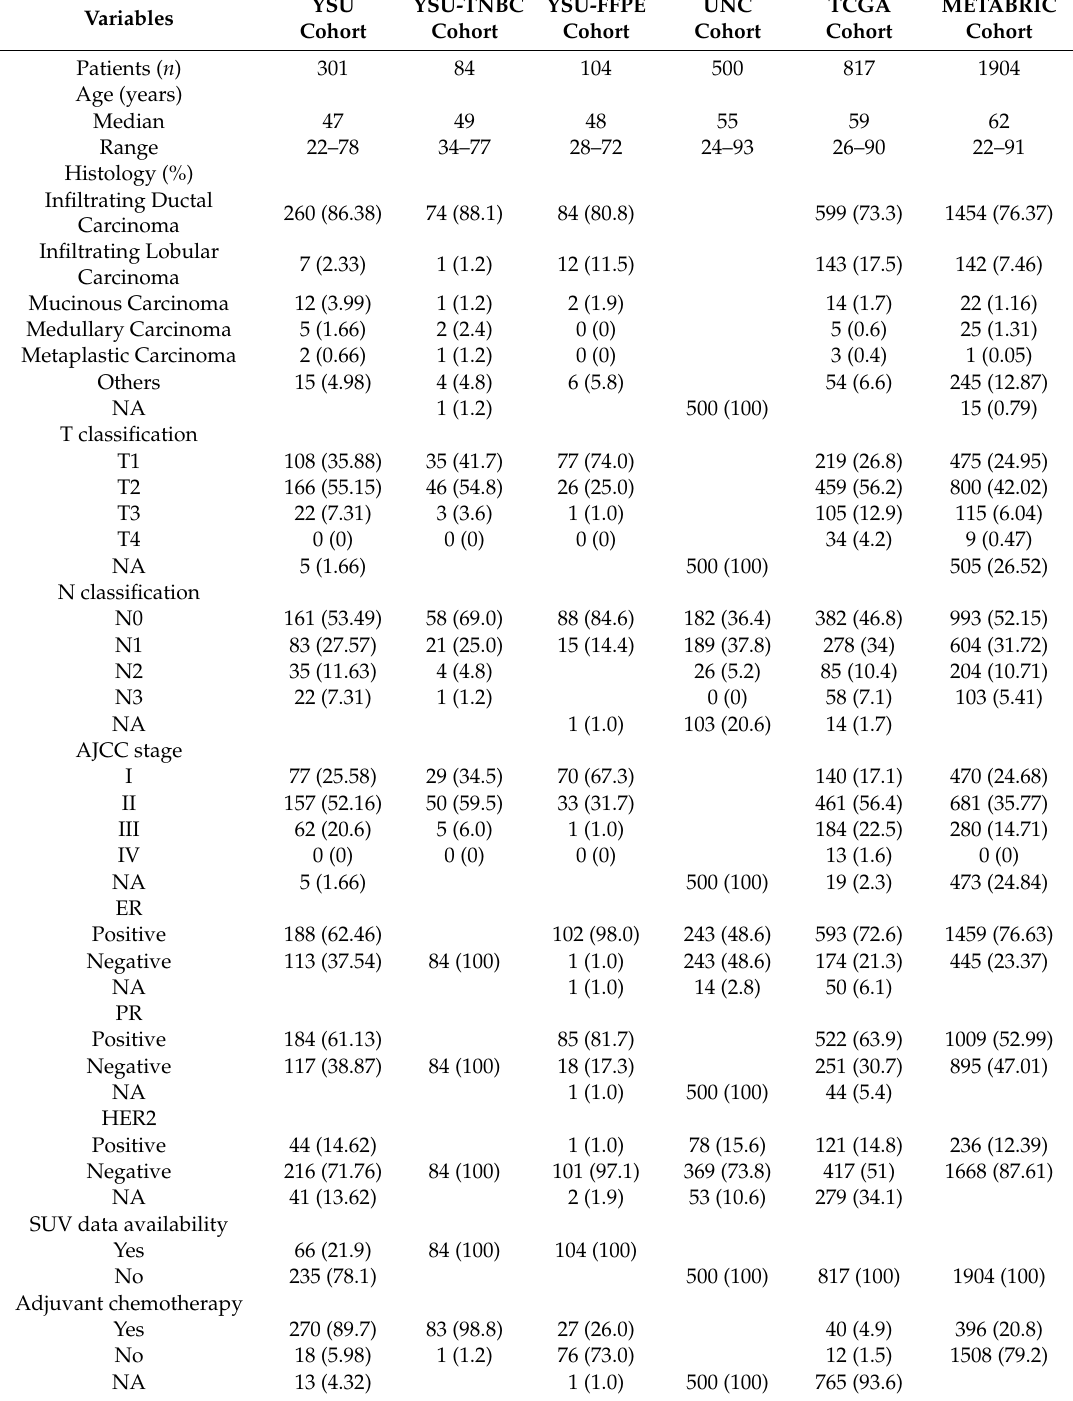
Table 1. Baseline characteristics of breast cancer patient